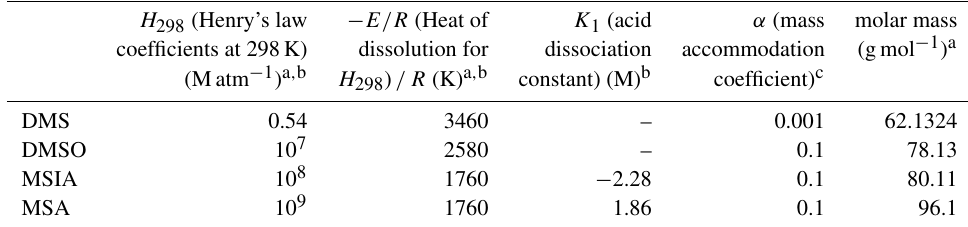
Table 8. Summary of parameters of DMS and its oxidation intermediates used in this study. H 298 (Henry’s law − E/R (Heat